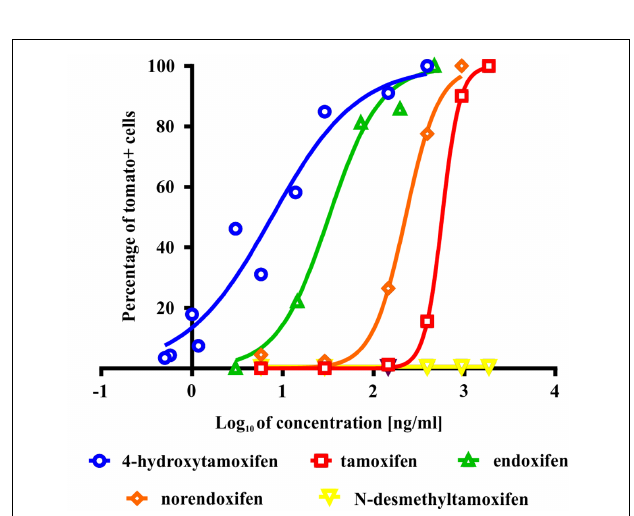
FIGURE 2 | Effectivity of tamoxifen and its metabolites in promoting recombination in vitro . The most potent metabolite of tamoxifen is 4-hydroxytamoxifen with EC = 7.6 ± 2.5 ng/ml, followed by endoxifen (EC = 32.1 ± 1.6 ng/ml), norendoxifen (EC = 224.5 ± 20.4 ng/ml), tamoxifen itself (EC = 553.4 ± 68.4 ng/ml) and inactive N